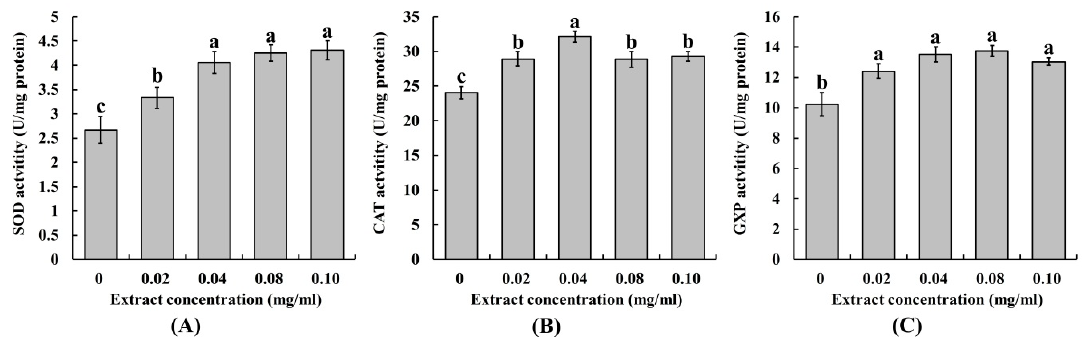
Figure 5. The effect of SIFs extract on the activities of antioxidant enzymes SOD ( A ), CAT ( B ), and GPX ( C ) in melanoma cells A375. Different small letters mean significant differences at p < 0.05. SOD: superoxide dismutase; GPX: glutathione peroxidase; CAT: catalase.